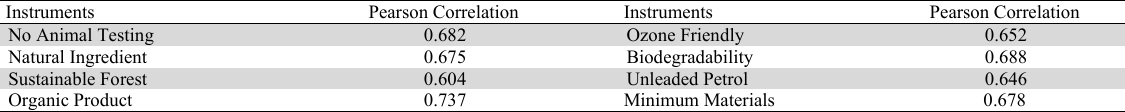
Instrument Tests for Environmental Knowledge (Cronbach’s Alpha = 0.905)